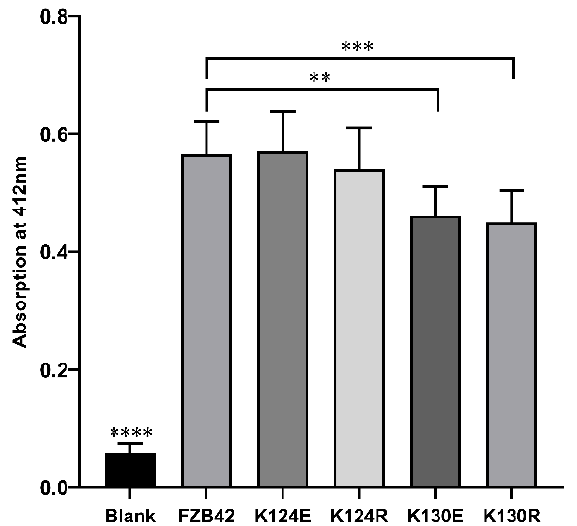
Figure 7. In vitro enzymatic activities of the intact LuxS of FZB42 and its derivates with mutations. ** ( p = 0.0023), *** ( p = 0.0008), **** ( p < 0.0001).